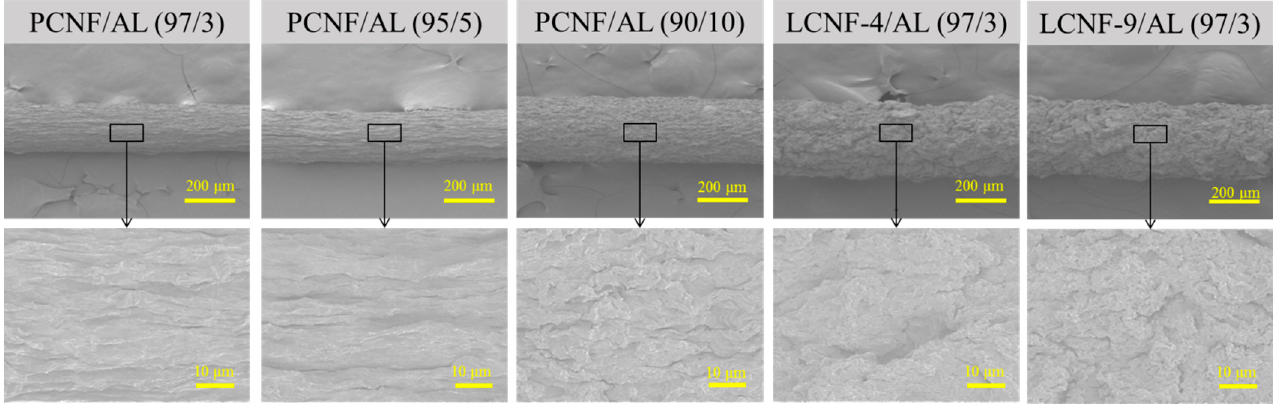
Figure 3. The effect of AL addition in LCNF suspension on wet-spinnability.